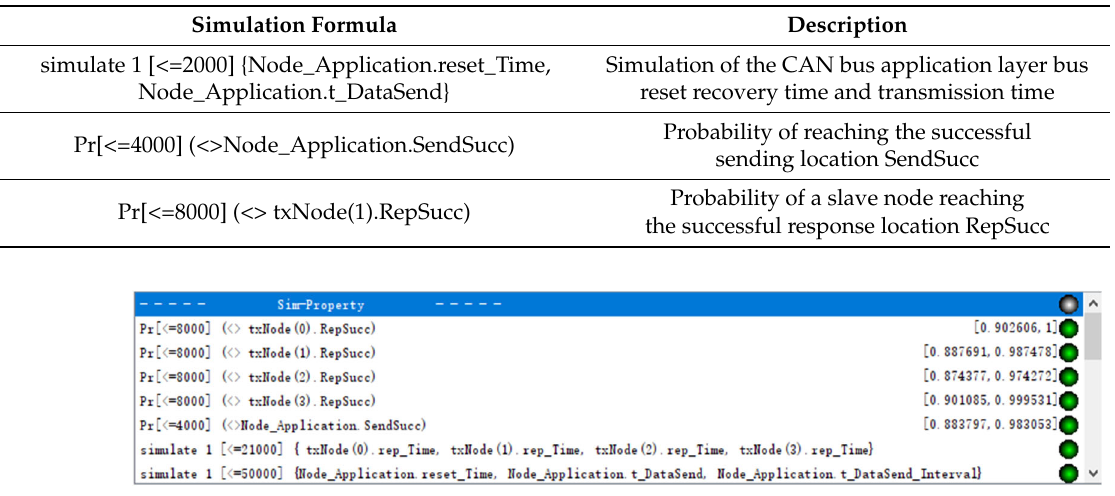
Table 5. UPPAAL SMC simulation formula.